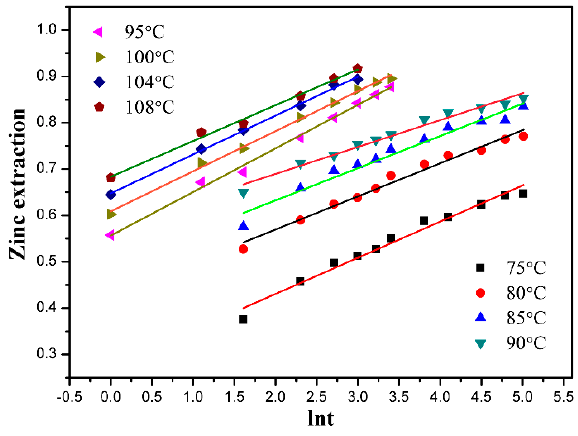
Figure 7. Plot of zinc extraction versus ln t for different temperature.